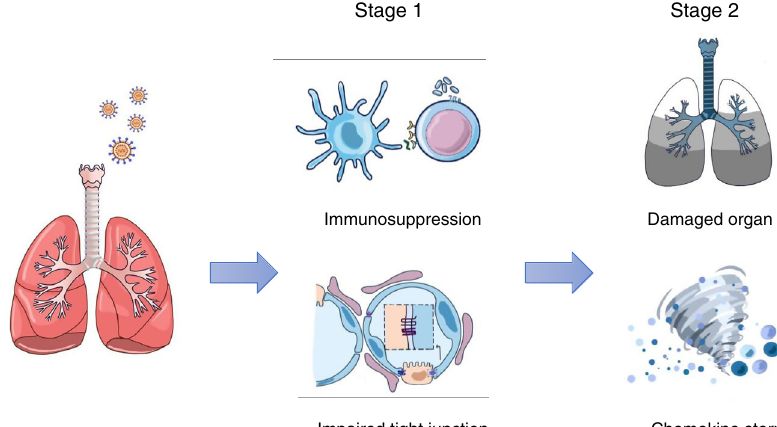
Fig. 4 A “ two-stage ” model of COVID-19 pathogenesis. The fi rst stage of COVID-19 might involve suppression of the immune system and damage to tight junctions. The second stage might involve activated immune responses, contributing to cytokine storm and organ